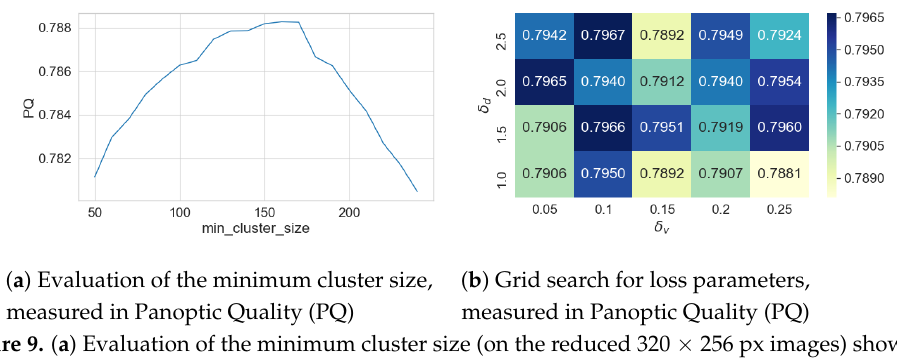
Figure 9. ( a ) Evaluation of the minimum cluster size (on the reduced 320 × 256 px images) showing a stable interval in the range 80 to 200; ( b ) Panoptic Quality (PQ) for different thresholds δ v and δ d which control the distances in the discriminative loss.